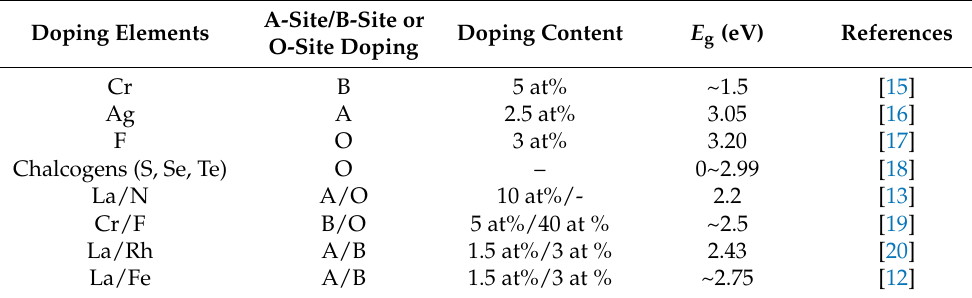
Table 1. Properties of Sr 2 TiO 4 doping with differentiation. Doping